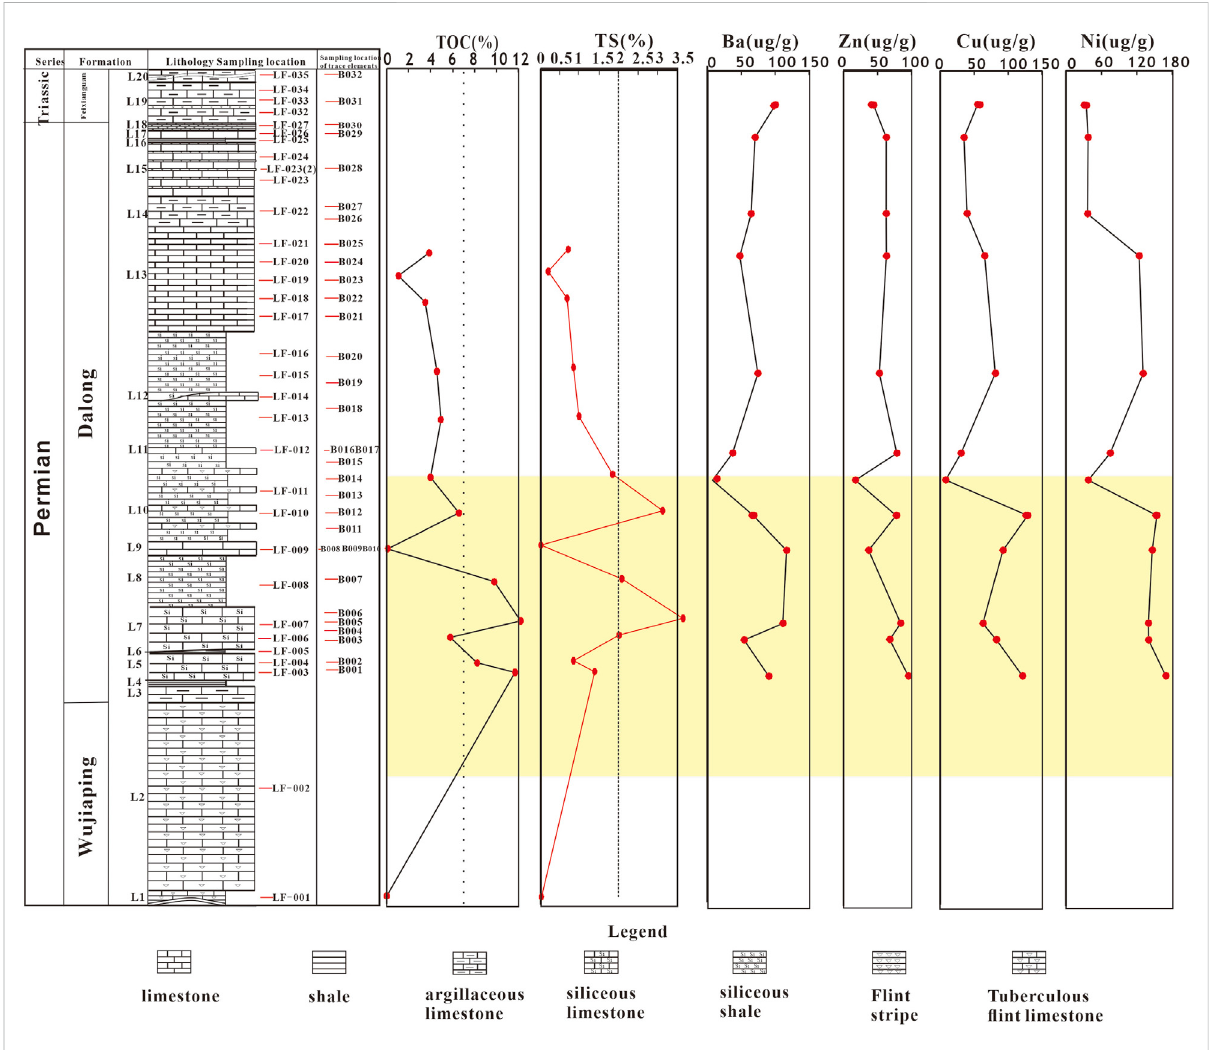
FIGURE 3 Vertical trends in TOC, redox indicators, and paleoproductivity proxies of the Dalong Formation. TS, total